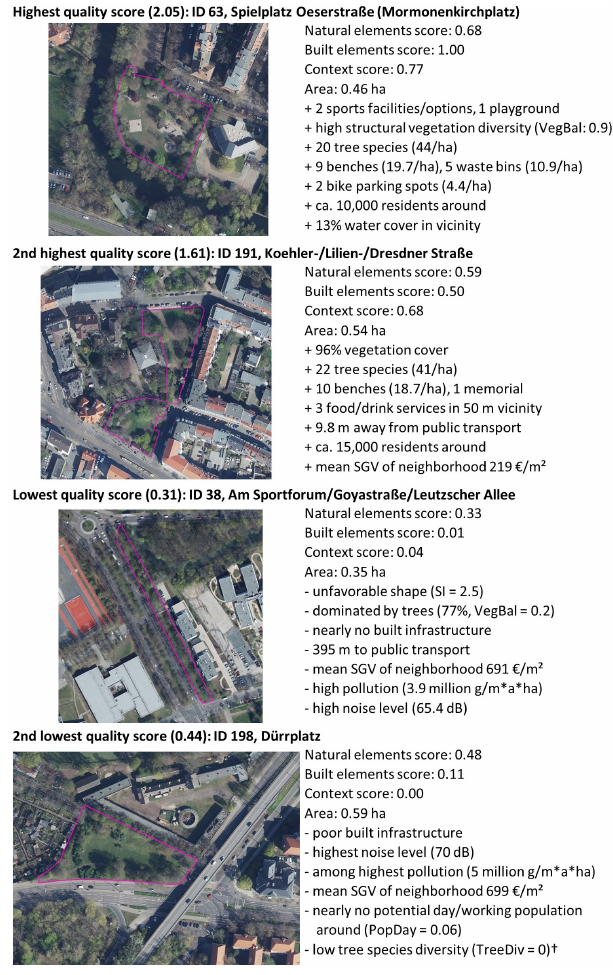
Fig. 8 . Details for the parks (purple outline) with the two highest and lowest quality scores. Special positive features are marked with plus signs (+), negative features with minus signs (-). The size of each park has no particular negative or positive effect in the respective calculations. Note: SGV = standard ground value. †Note: this is due to incomplete tree cadaster dataset; actual tree cover of 44%. Source of background imagery: City of Leipzig, Amt für Geoinformation und Bodenordnung.